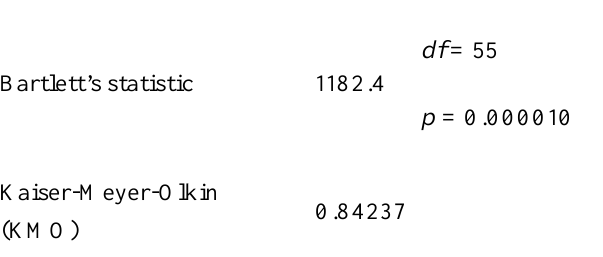
Bartlett’s statistic